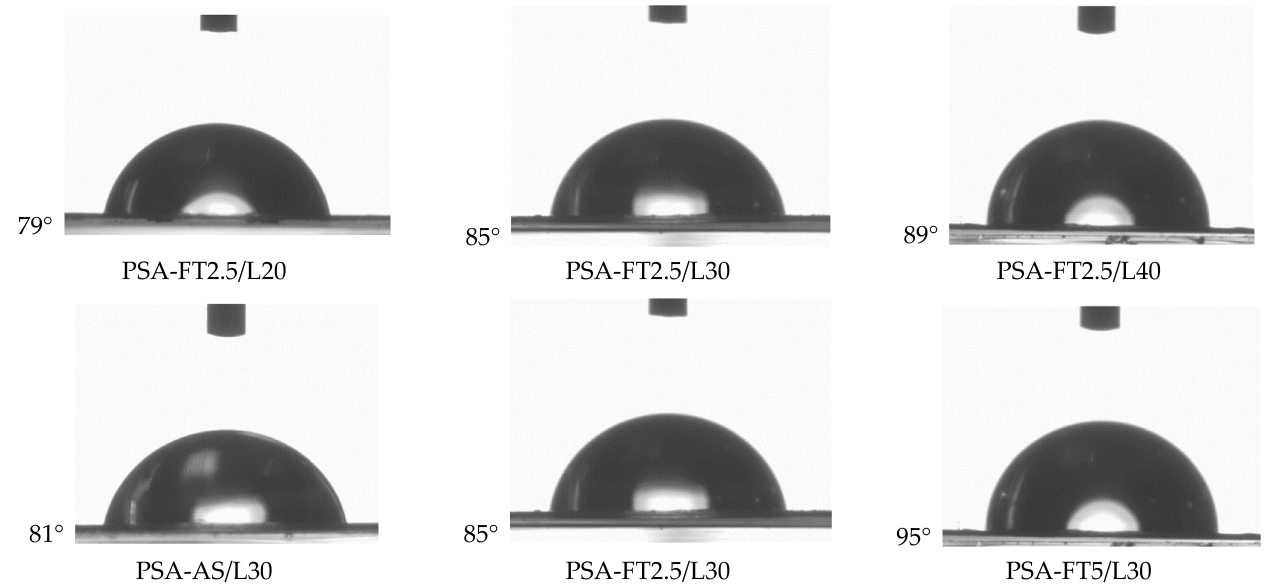
Figure 10. Contact angle values for water on the PSA surfaces in relation to LMA and fluorotelogen content in the FT-type syrups (PSA with 6 wt. parts of L9033; UV dose of 8 J/cm 2 ).